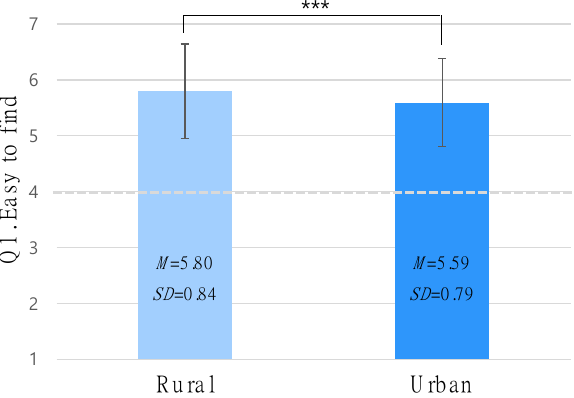
Figure 12. The environment’s main effect on Q1. Signs in rural areas were easier to find (*** p < 0.001).